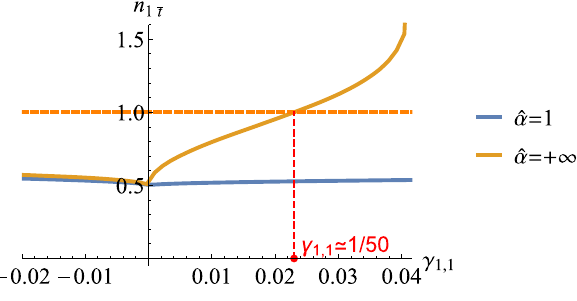
Fig. 26 ˜ n 1 ¯ t as a function γ 1 , 1 for representative ˆ α Fig. 27 m